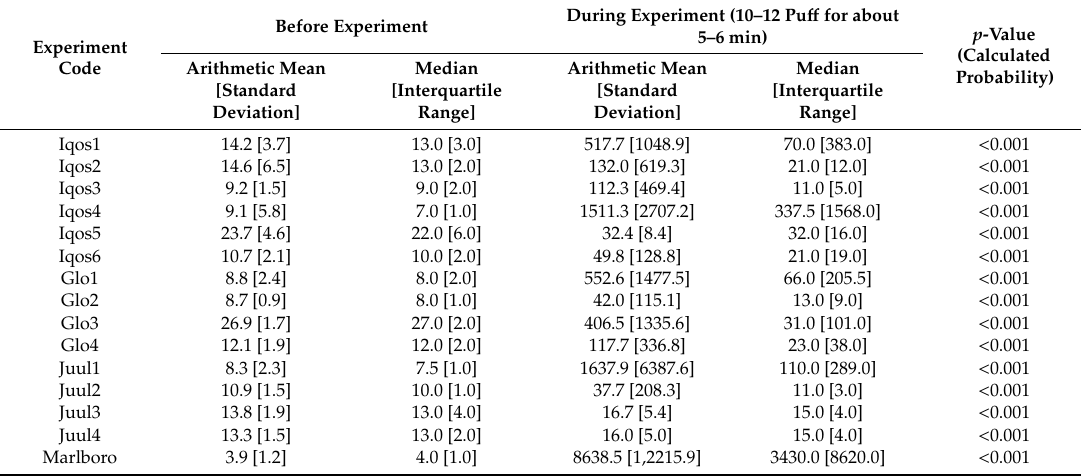
Table 2. Air levels of PM with an aerodynamic diameter smaller than 1 µ m (PM 1 ; µ g m − 3 ) before and during each